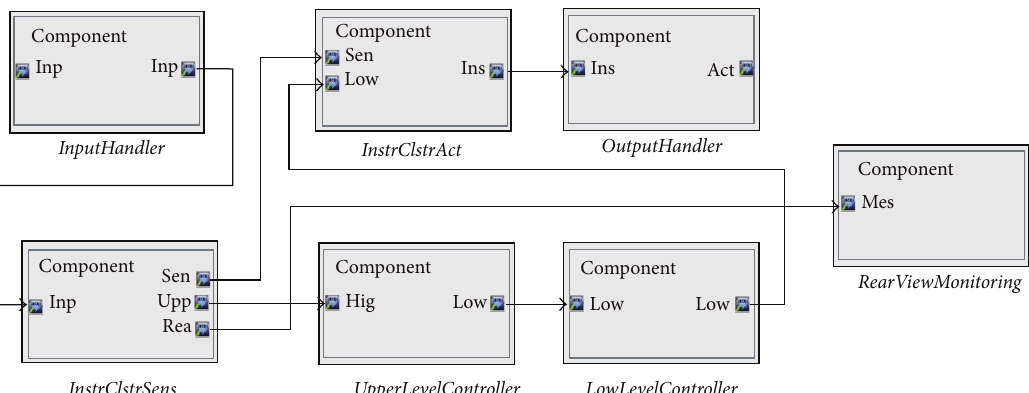
Figure 8: Logical software architecture of ACC controller.